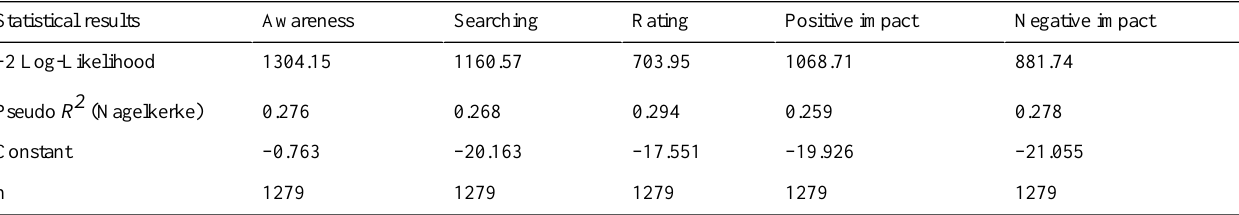
Negative impactPositive impactRatingSearchingAwarenessStatistical results